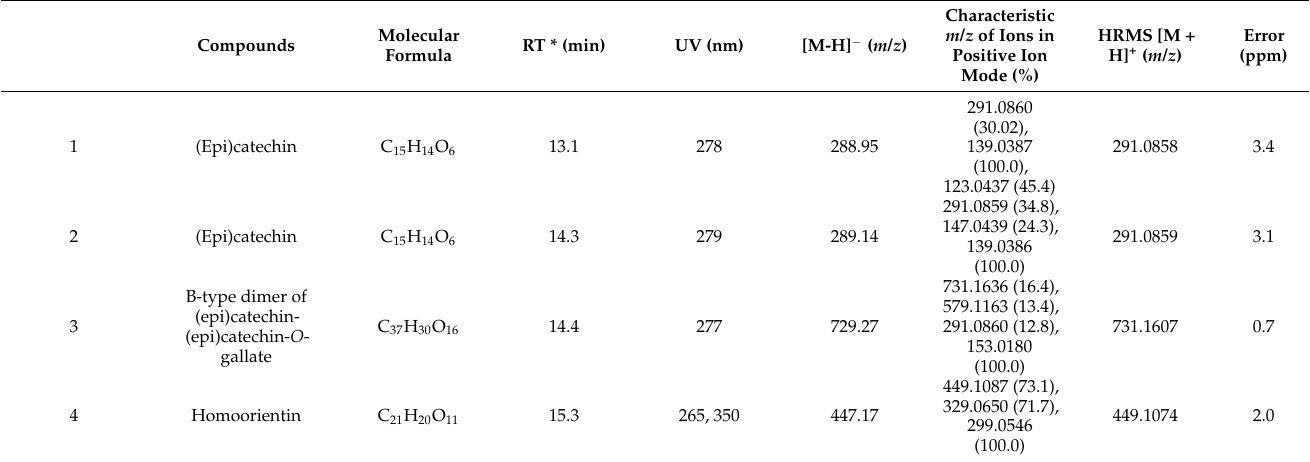
Figure 1. Chemical structures of flavonoids from the leaves of Curatella americana . Table 1. Spectroscopic data and characterization of polyphenols in leaf ethanolic extract from Curatella americana by